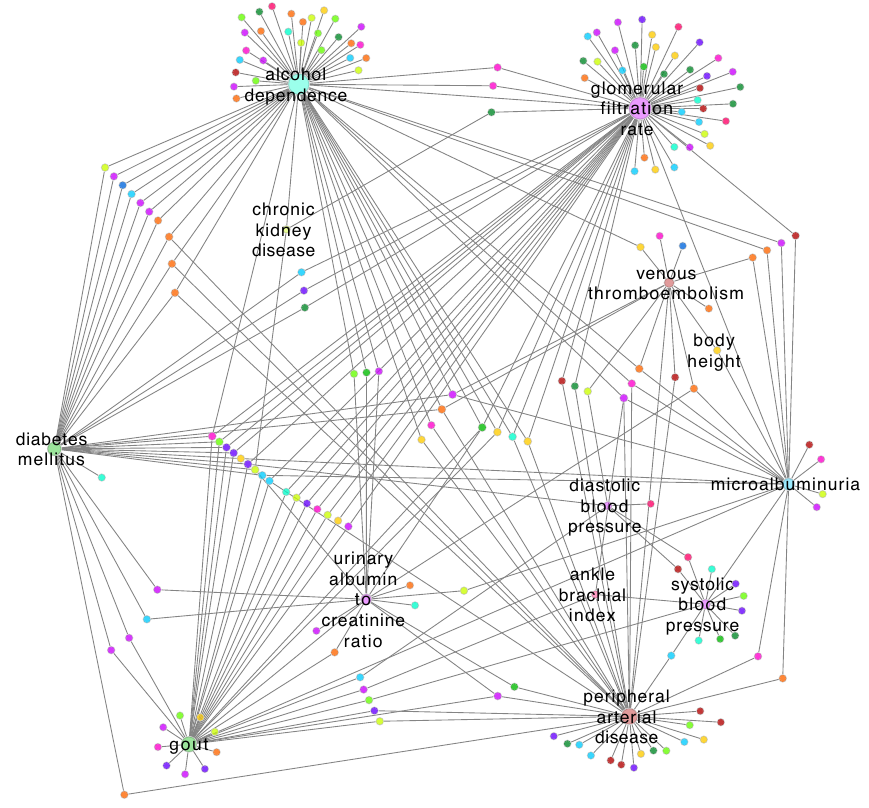
Figure 6. Disease connections that emerge from MVP data. Subgraph containing 196 traits and 297 edges that were formed only by the inclusion of genetic variant associations from the Million Veteran